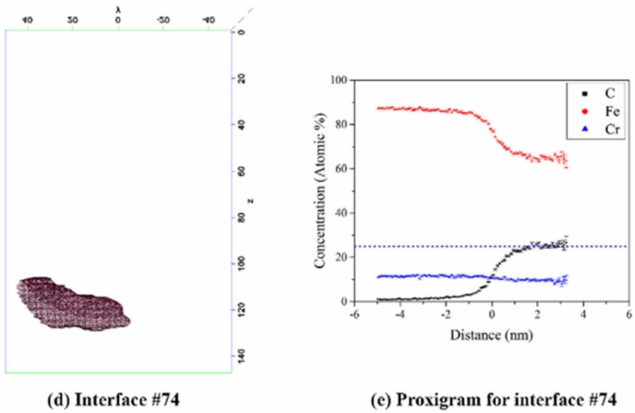
Figure 9. Example of the atom probe data obtained from tempered martensite microstructures. Alloy shown is 11Cr alloy after deep cryogenic treatment (DCT) and tempering. Dotted line in ( e ) represents stoichiometric Fe 3 C, 25 at.% C. Note the lack of Cr partitioning to any feature within the analyzed